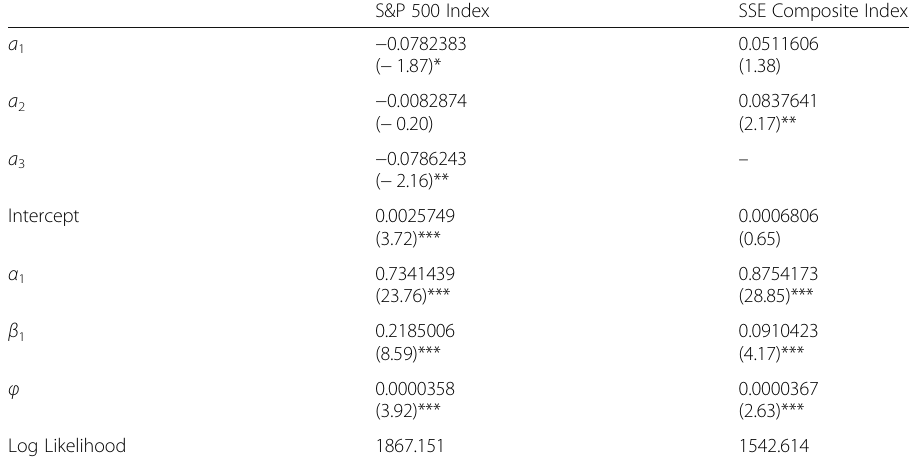
Table 5 Parameter estimates for the AR(p)-GARCH (1,1) process. The table reports the parameter estimates for the AR( p )-GARCH (1,1) processes. The notations come from expressions (2.2), (2.40), and (2.41). The numbers in parentheses are the t -ratios. The t -ratios marked with asterisks (double asterisks or three asterisks) indicate that the corresponding coefficients are statistically different from zero at the 10% (5% or 1%) level of